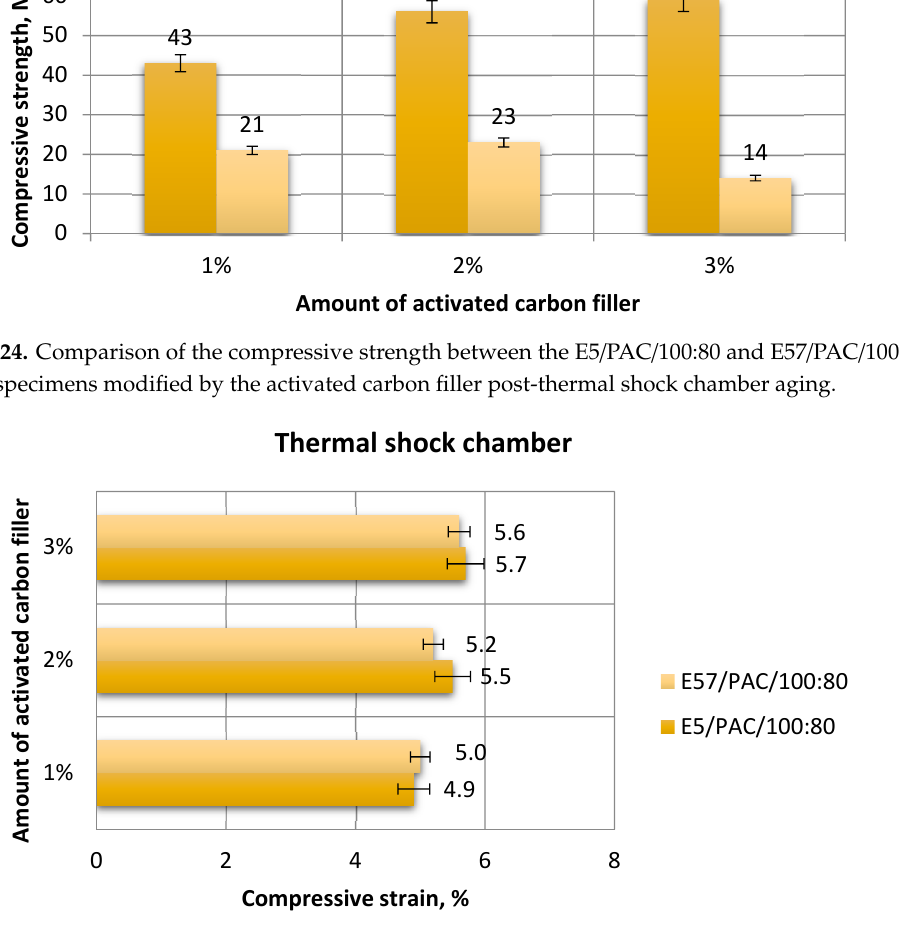
Figure 25. Comparison of the compressive strain between the E5/PAC/100:80 and E57/PAC/100:80 epoxy specimens modified by the activated carbon filler post ‐ thermal shock chamber aging.